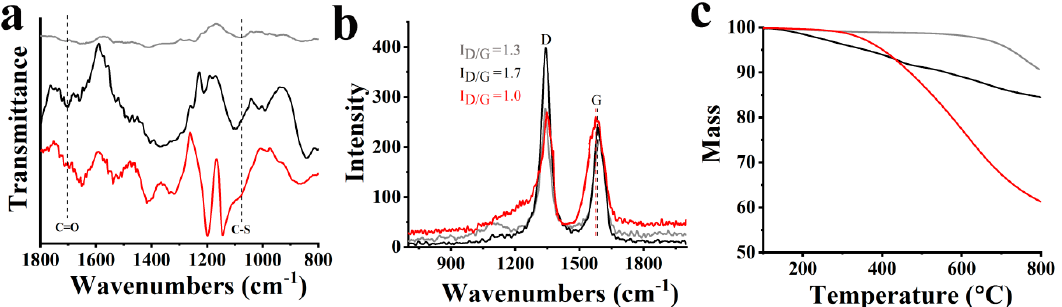
Figure 2. ( a ) ATR-IR spectra, ( b ) Raman spectra (514 nm), and ( c ) thermogravimetric analysis graphs obtained under nitrogen atmosphere of S-CNHs (red), ox-CNHs (black) and pristine CNHs